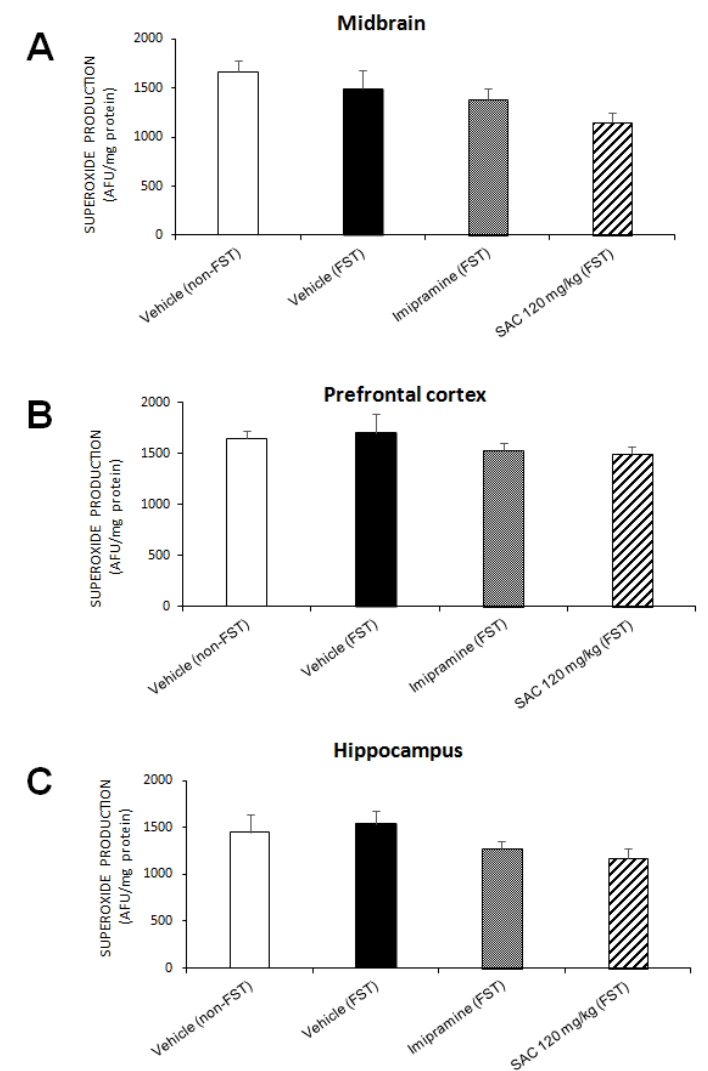
Figure 4. Effect of SAC on O 2 •− production in several brain regions in mice subjected to FST.